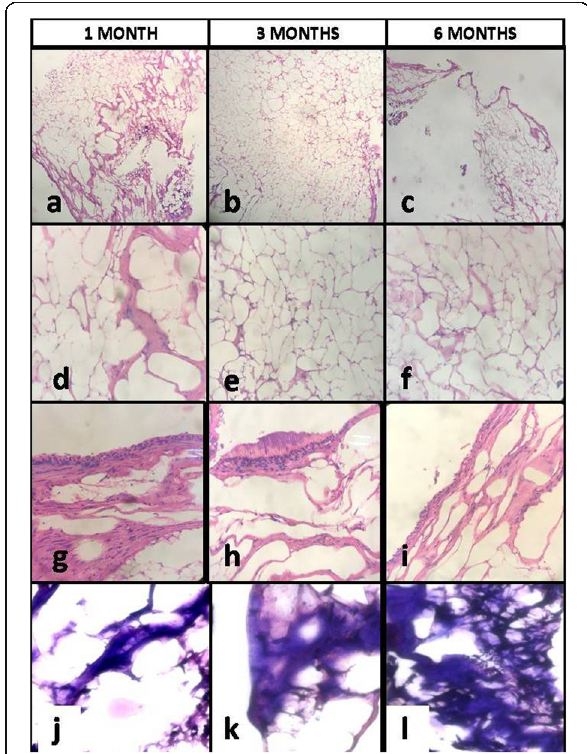
Fig. 5 Histology and microbiology of dental pulp after 1 and 2 years of extraction. a , b Thin strands and streaks of EMC seen (× 100). c Basophilic nuclear debris of the fibroblasts seen (× 400). d No nuclear debris appreciated (× 400). e , f Tissue Gram stain (Brown and Brenn) highlighting the presence of Gram-positive Staphylococci and Streptococci (×